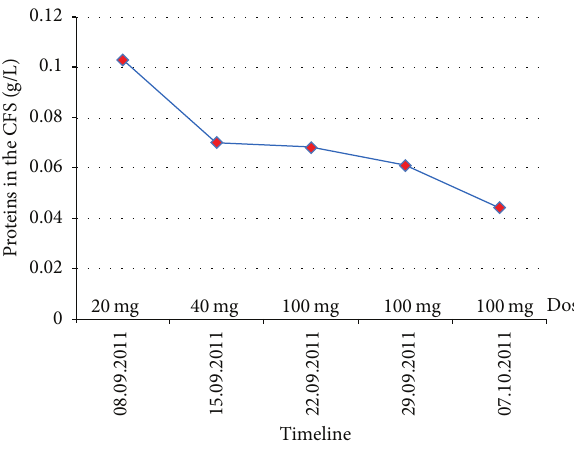
Figure 3: Decreased values of the proteins in the CSF by Ommaya punction, during the treatment with IT